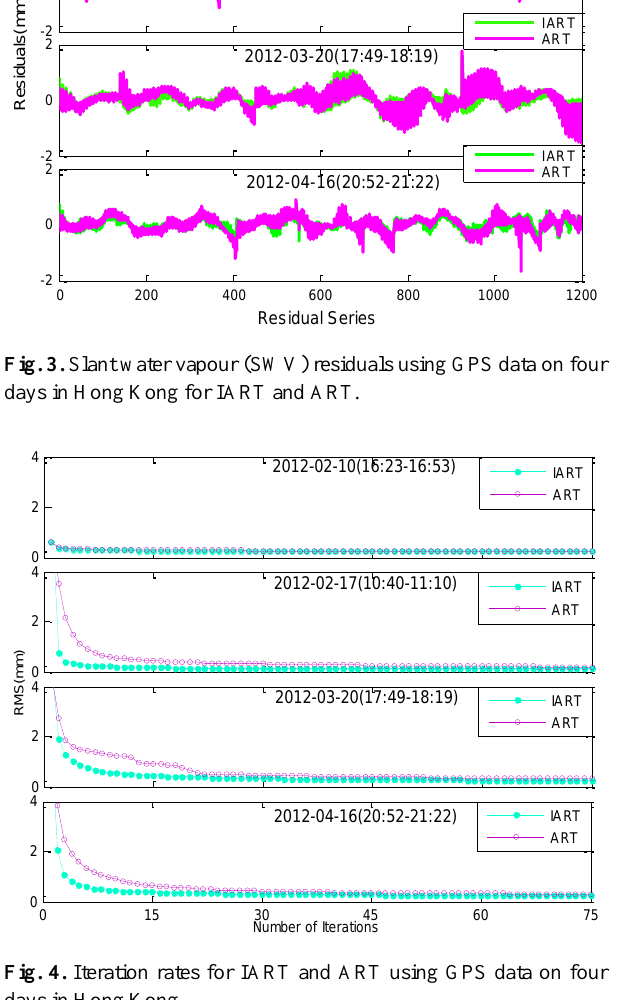
Fig. 4. Iteration rates for IART and ART using GPS data on four days in Hong Kong.